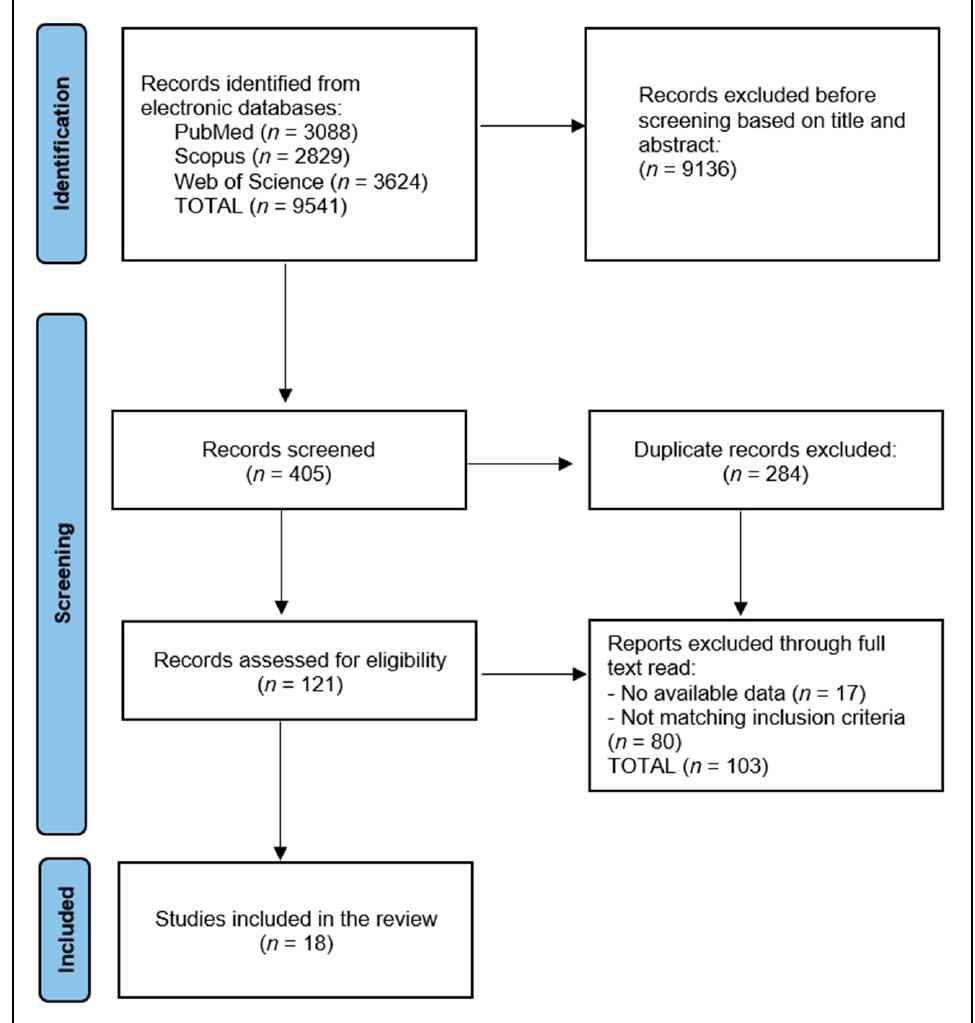
Figure 1. PRISMA flow diagram.